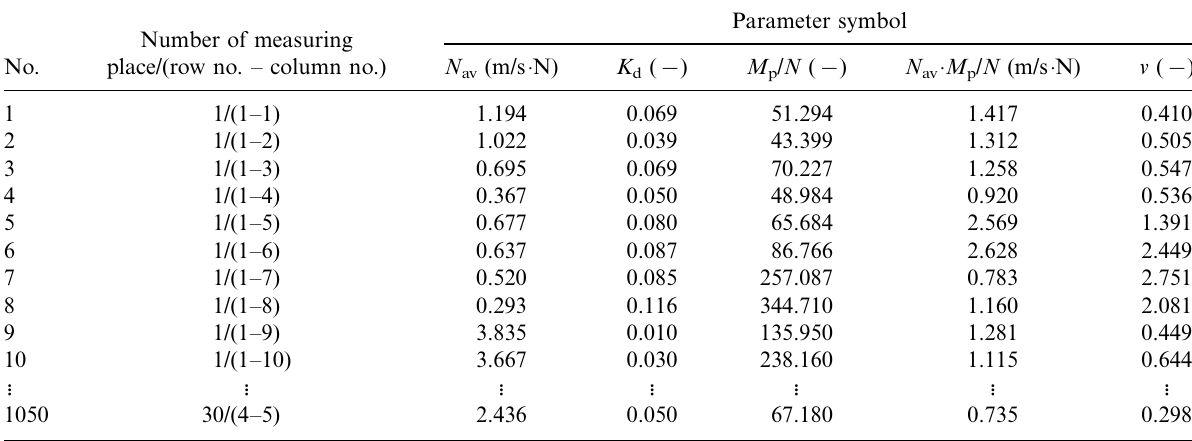
Parameter symbol